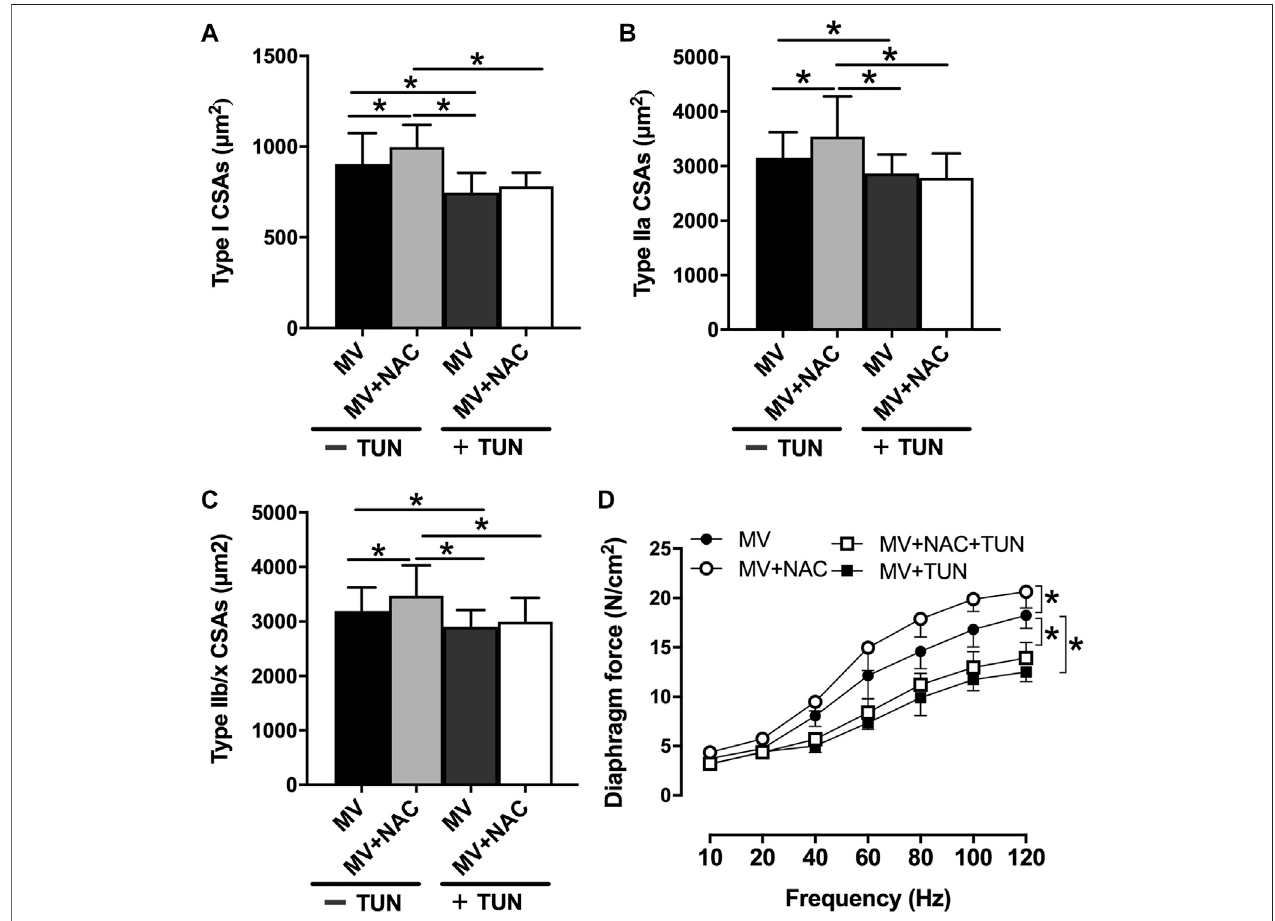
FIGURE 7 | ER stress induces diaphragm dysfunction in the absence of oxidative stress during MV. (A – C) Measurement of CSA indicated that induction of ER stress enhanced diaphragm atrophy in rats treated with or without NAC. In addition, diaphragm strips were studied ex vivo to evaluate force-generating capacity (D) . TUN worsened diaphragm weakness in the presence and absence of oxidative stress in rats in theMV groups. * p < 0.01 (ANOVAfollowed by theTukey HSD test, n = 6 per group). NAC = N-acetylcysteine, MV = mechanical ventilation, TUN = tunicamycin.